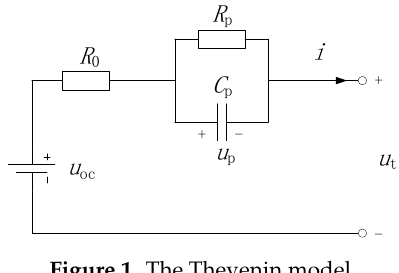
Figure 1. The Thevenin model.